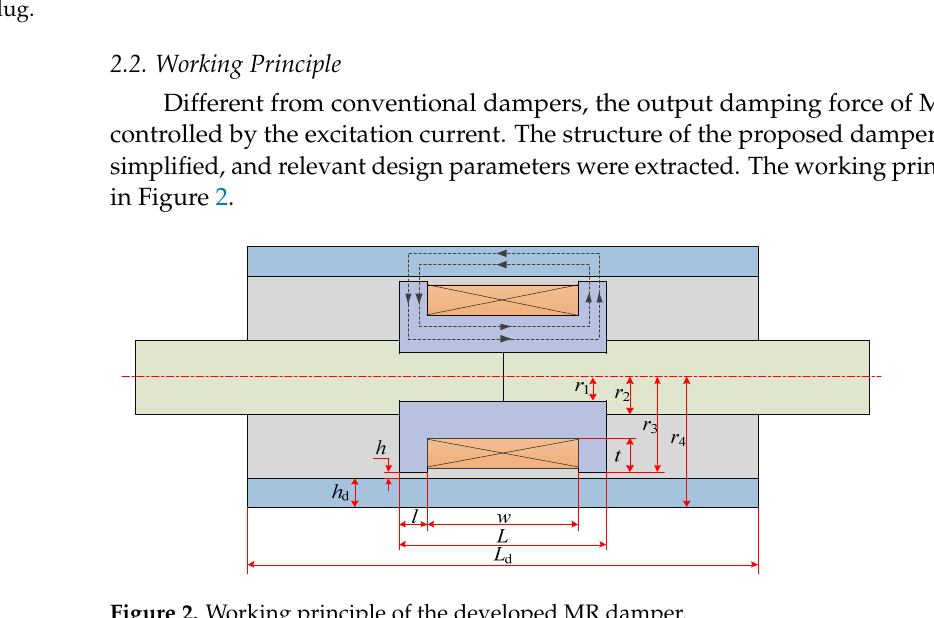
Figure 2. Working principle of the developed MR damper.